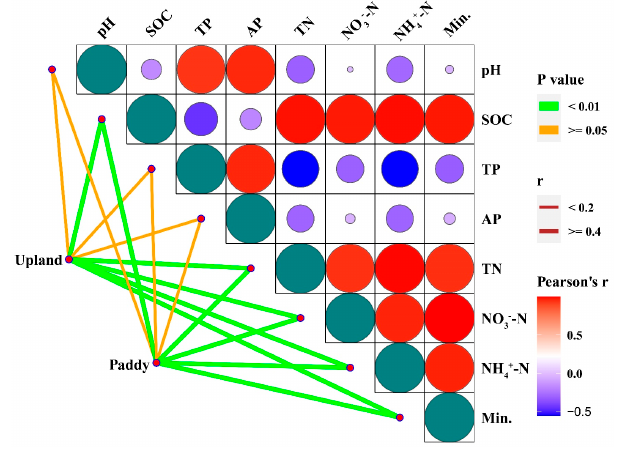
Figure 5. Correlation heatmap analysis between soil properties and the net N mineralization in upland and paddy soils. In anaerobic conditions, microbial activities and the decomposition of SOM are rela- tively slower than in aerobic conditions [88]. Figure 6 shows the proportional contribu- tions based on results from variation partitioning analysis (VPA), explaining the contri- bution of biotic factors (SMBC, SMBN, LAP, NAG), abiotic factors (pH, SOC, total N, total and available P) and N content (NO 3 − -N and NH 4+ -N) to the net N mineralization. The biotic factors and N contents explained most of the variations related to net N mineraliza- tion based on the variance portioning analysis. The greater proportion of variation was accounted by biotic rather than by abiotic factors (Figure 7) was likely because biotic fac- tors such as soil microorganisms are directly involved in the decomposition of soil organic matter and stimulate microbial activities [89]. The total variance of net N mineralization was explained by the abiotic and biotic factors linked with the improved environmental